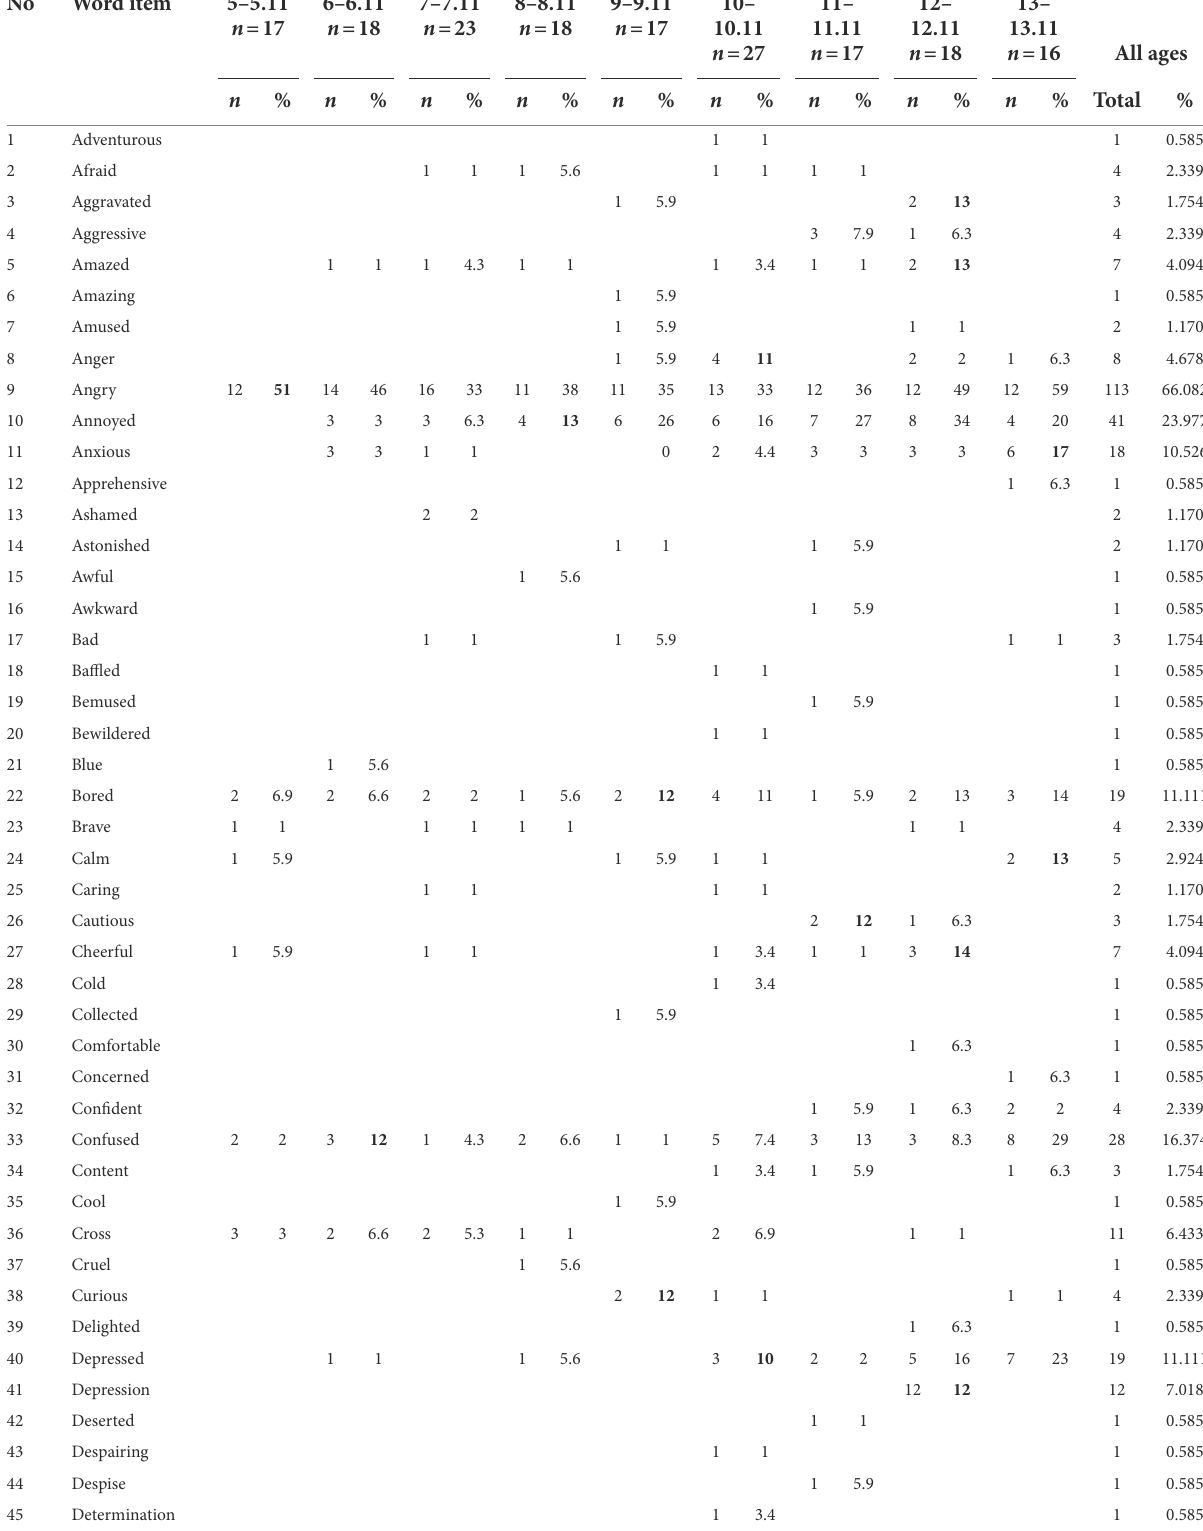
TABLE 4 Showing all correct word items generated in the WA:Emo task (1) total number of occurrences for each word per age group, (2) percentage of children generating each word in each age group, (3) total number of times each word was generated across all ages, (4) percentage of all children generating that word, (5) total number of words generated by each age group, (6) average number of words generated by females and males per age group.